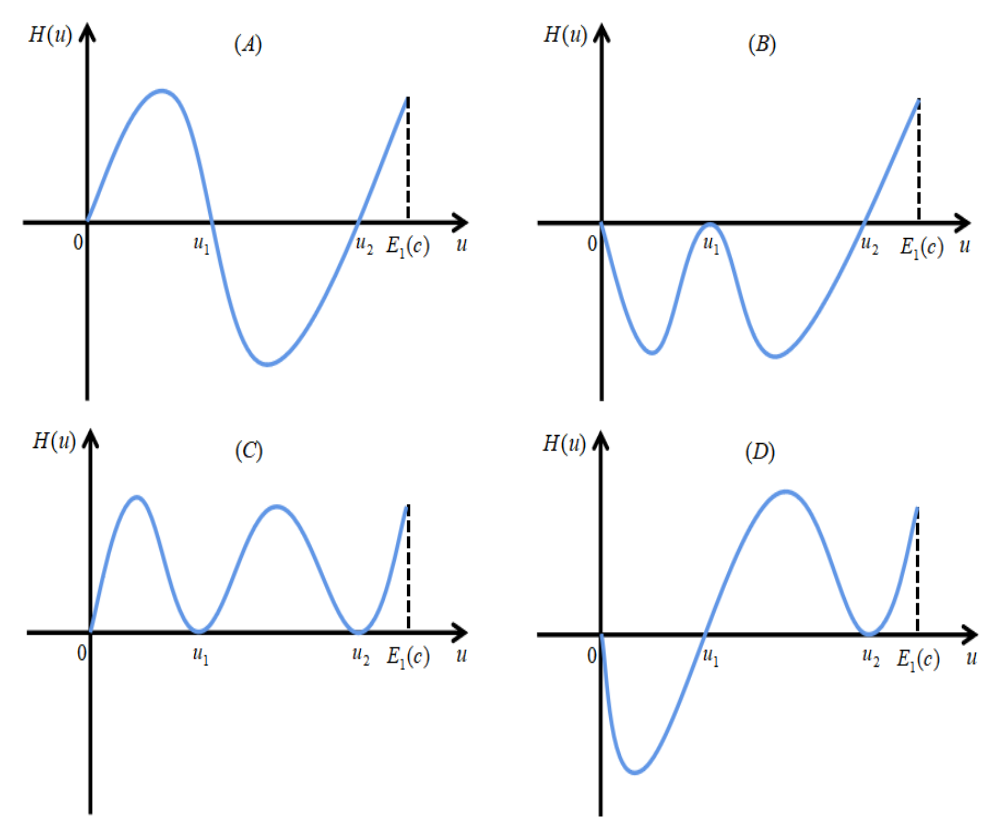
Figure 2. Panels ( A – D ) are four possible cases when H ( u ) = 0 has exactly two positive real roots for u ∈ ( 0, E 1 ( c ))